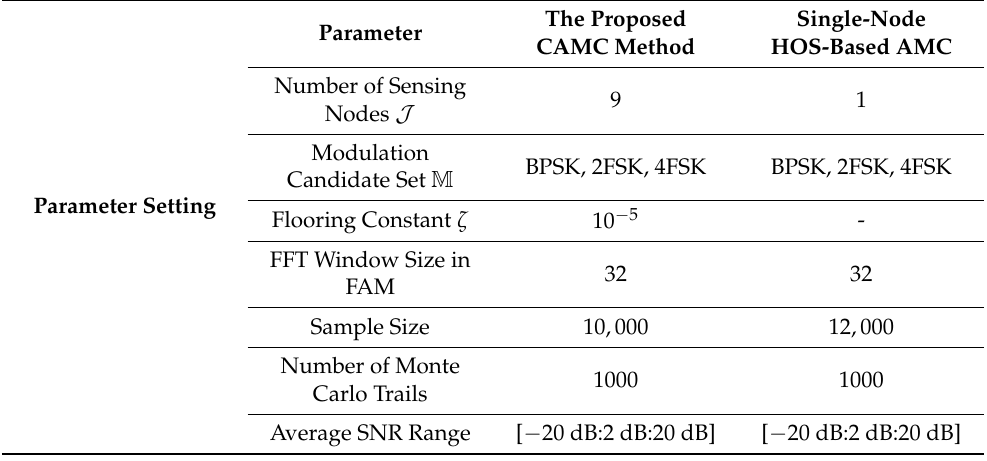
Figure 5. Probabilities of correct classification, P cc, versus average SNR for our proposed new VSDF CAMC approach and the existing single-node HOS-based AMC method in [24] in the presence of mul- tipath Rayleigh channels and AWGN over the modulation candidate set ˜ M def = { BPSK,2FSK,4FSK } . Thus, our proposed new VSDF CAMC scheme remarkably outperformed the existing single-node graph-based and HOS-based AMC methods. Table 7. The parameter setting and the P cc’s of our proposed CAMC approach and the existing HOS-based AMC method in